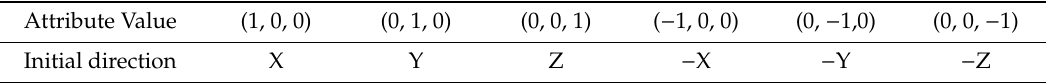
Table 1. Directions indicated by the second attribute of IfcExtrudedAreaSolid.